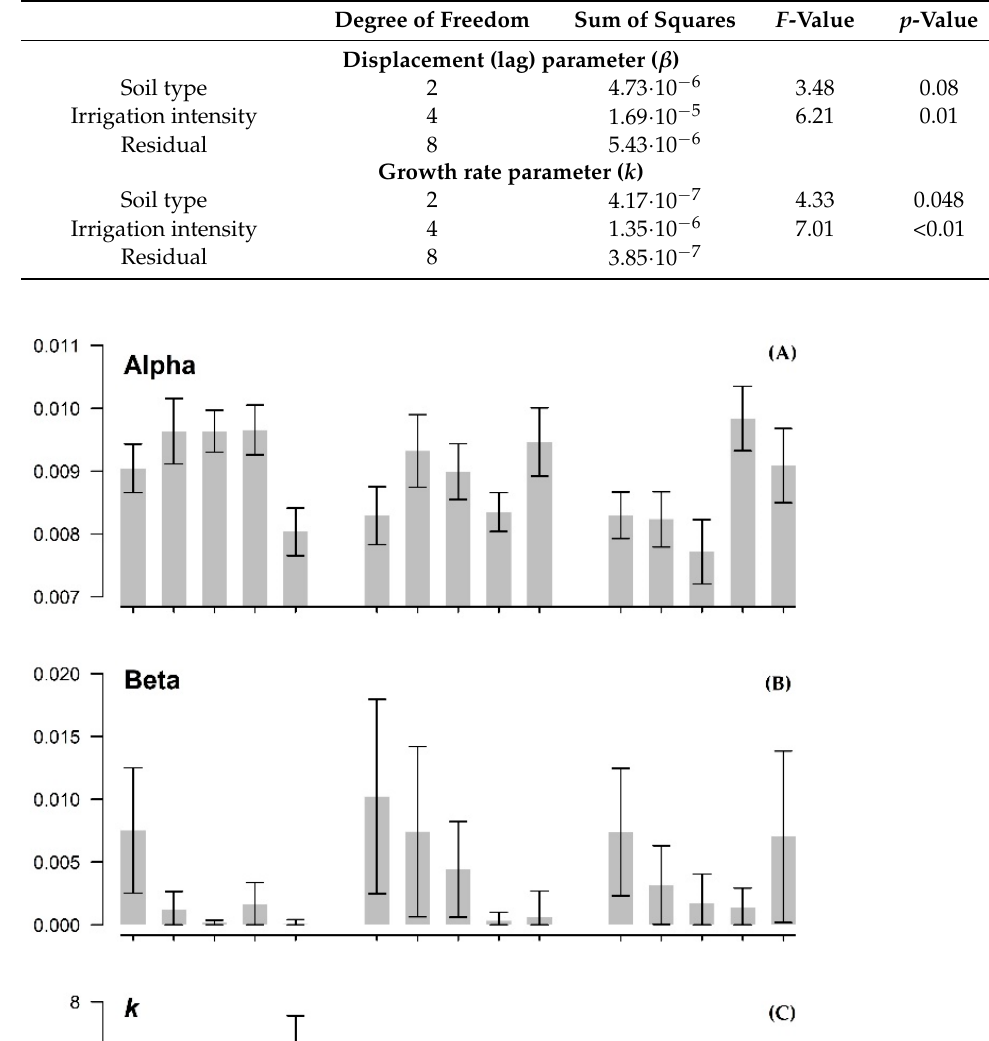
Figure 3. The asymptote (alpha) ( A ), displacement (beta) ( B ), and growth rate ( k ) ( C ) parameters of of the logistic regression of the relative increment of the third-year seedlings of Norway spruce